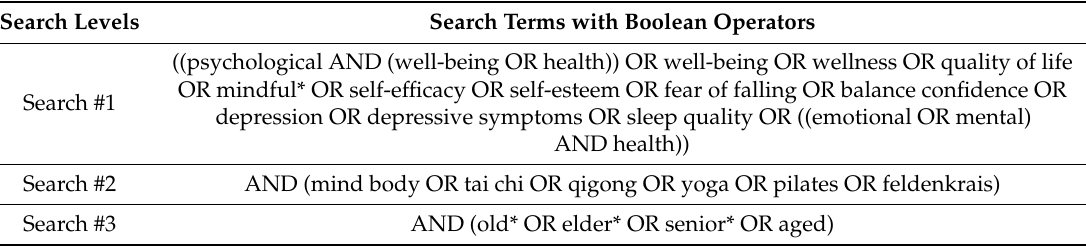
Table 1. Search levels and terms of the literature